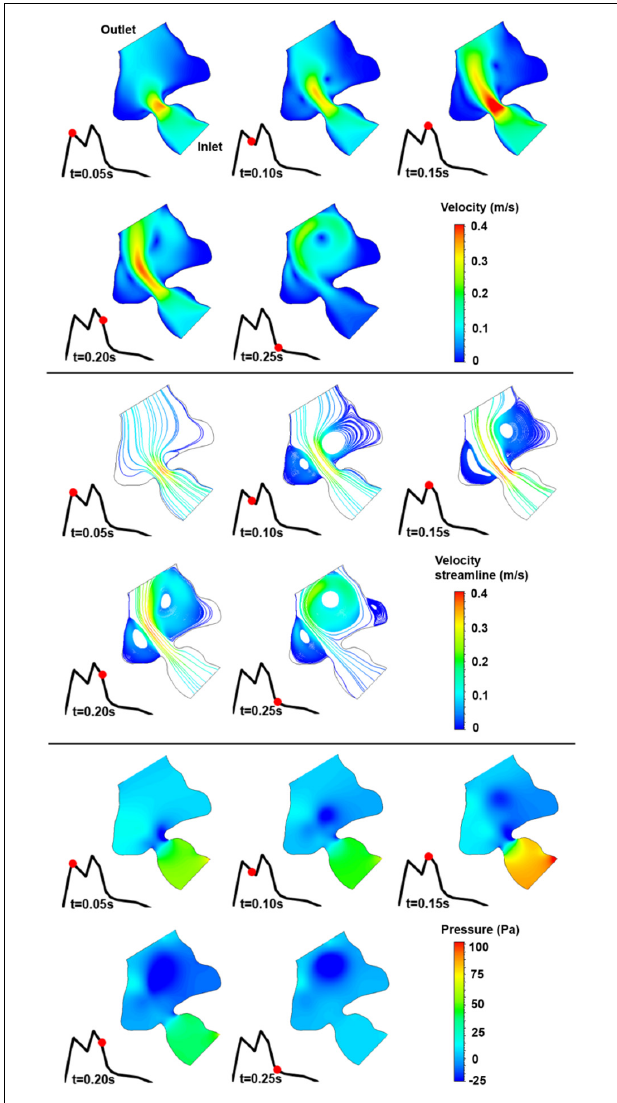
FIGURE 9 | Velocity magnitude, velocity streamline, and pressure contours for the control 2 heart at week 25. The instant in the cardiac cycle is shown near the